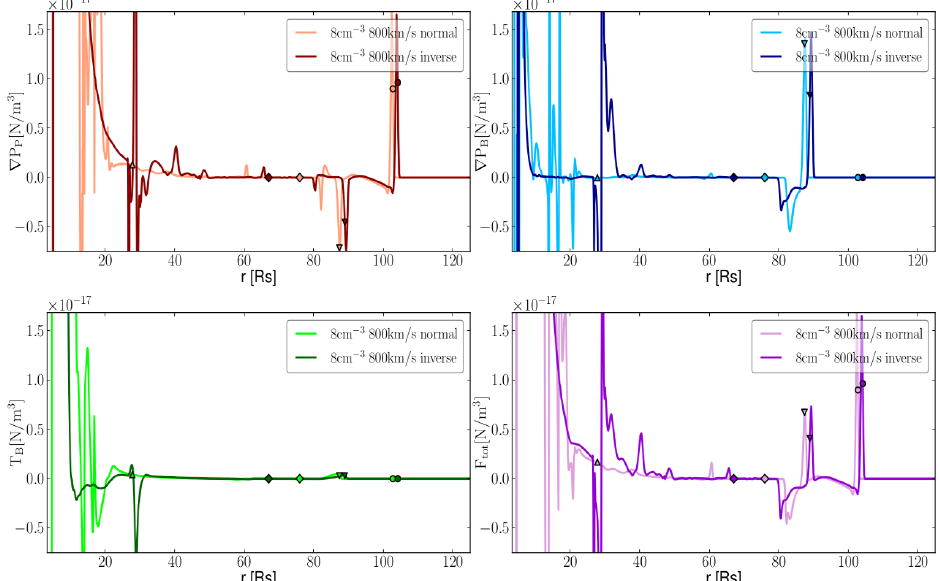
Figure 7. Forces in the equatorial plane at t = 20 h for a two CMEs ejected with a medium initial velocity in a middle density background wind but with a different polarity. Upper left panel: ∇ P ∇ P P . Upper right panel: B . Lower left panel: T B . Lower right panel: F tot . Locations of the shock, magnetic cloud edges and magnetic cloud centre are represented by circles, triangles and diamonds,